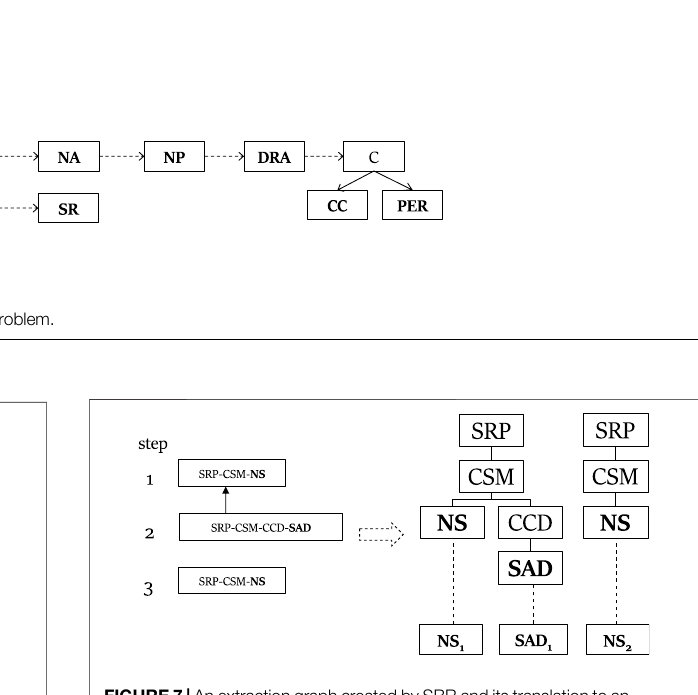
FIGURE7| An extraction graphcreated bySBRand itstranslationtoan